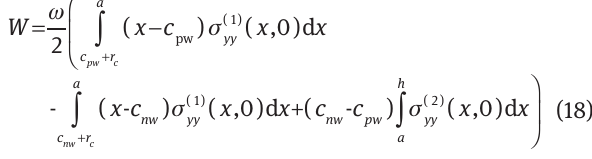
Figure 4 Dependence of the strain energy of a wedge disclination dipole on its position c (A) different values of K = λ = 0. The energy values are given in units of μ μ Ω Ω